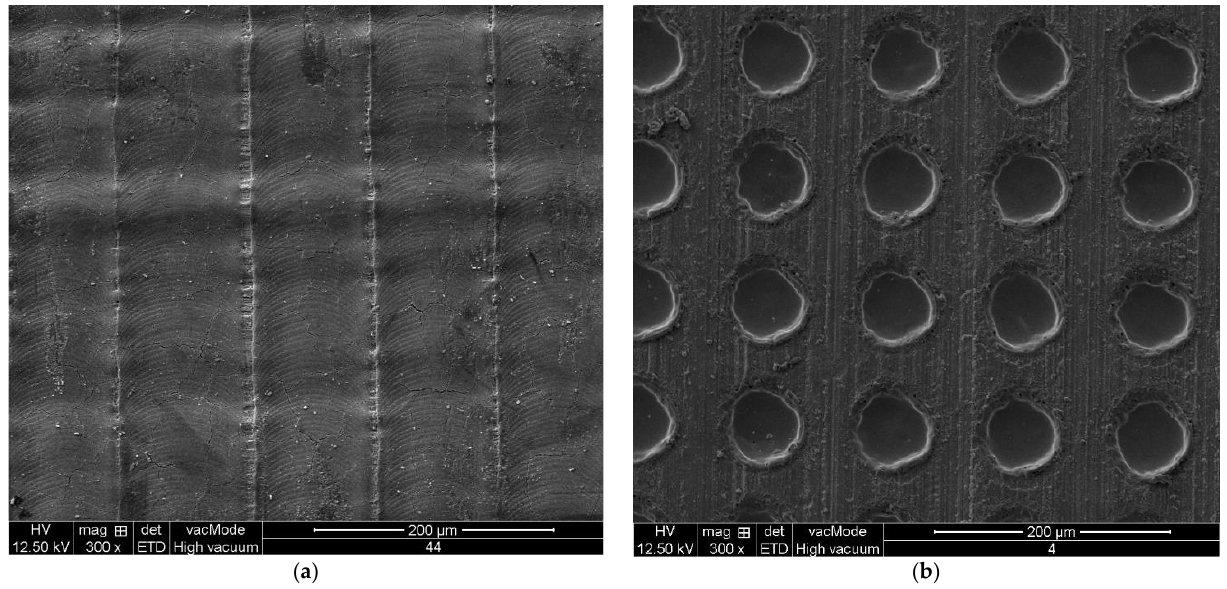
Figure 4. Two laser-structured workpieces with different laser parameters ( f = 49 kHz, V = 4900 mm/min, S 1 = 100 μm ). ( a ) N = 1; ( b ) N = 40.